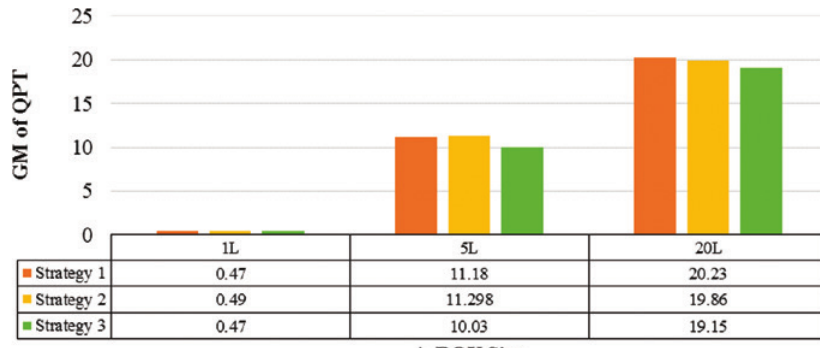
Figure 12: GM Analysis of Three Strategies.